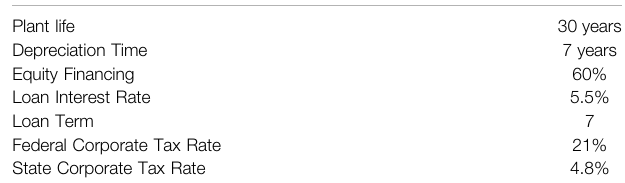
TABLE 7 | Financial parameters for discount cash fl ow